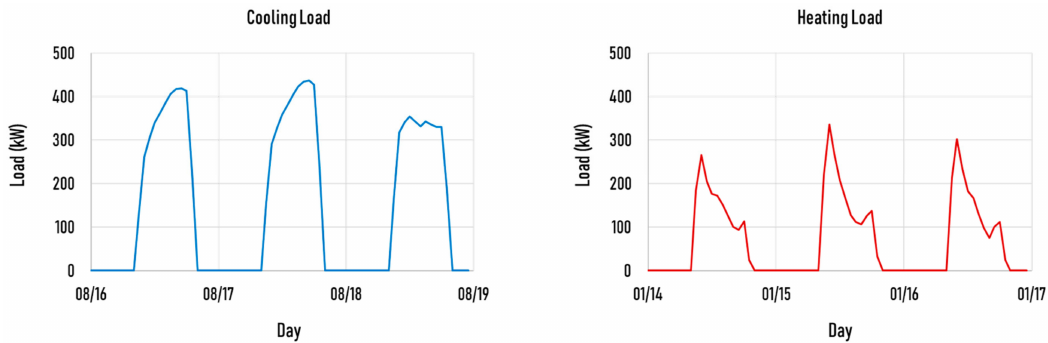
Figure 5. Daily load